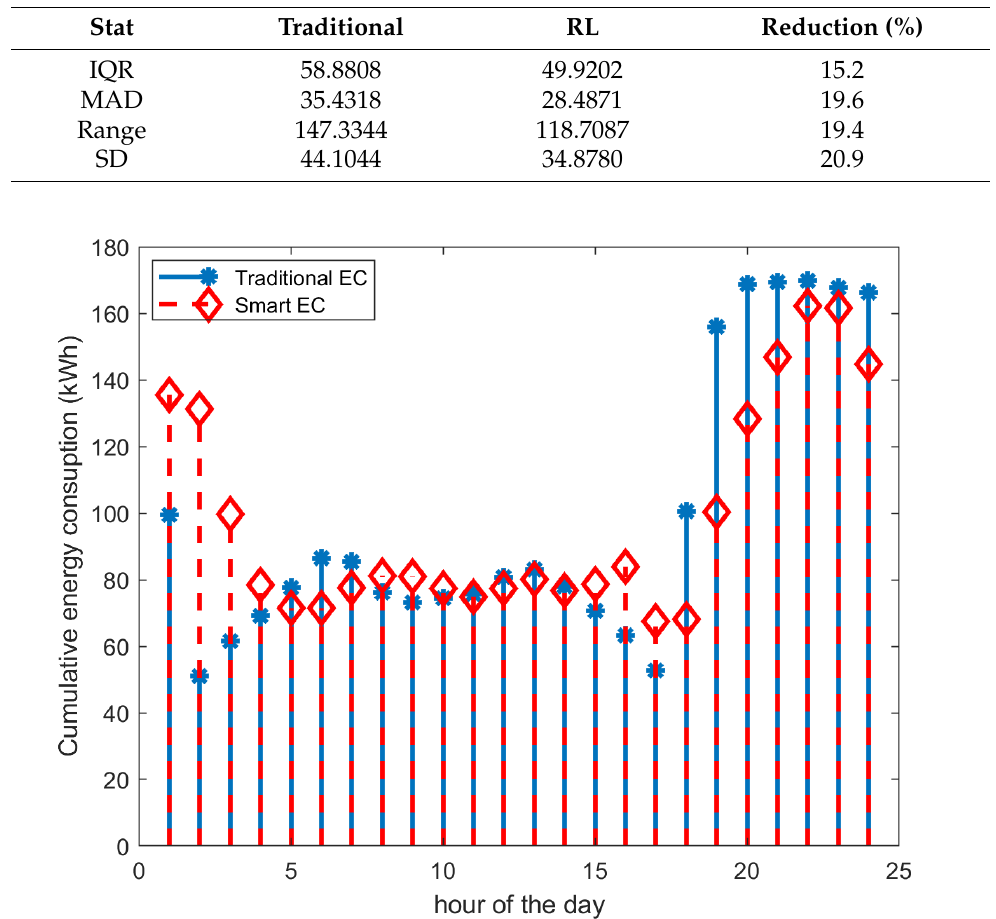
Table 3. The statistic dispersion results on the synthetic dataset.